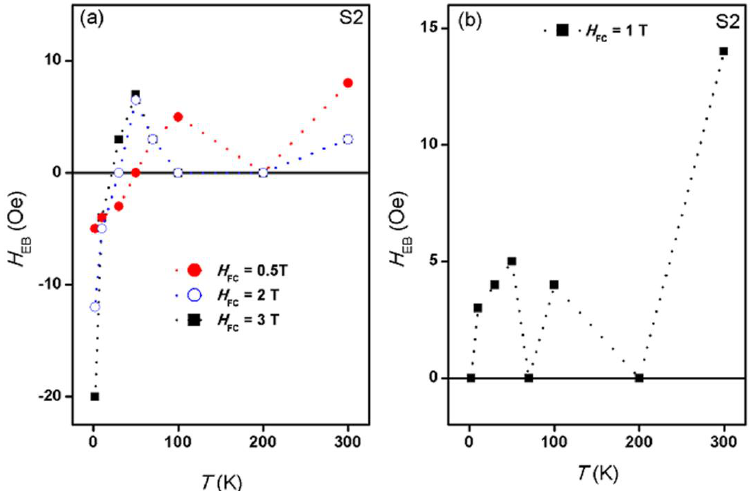
Figure 7. The temperature dependence of H EB in the temperature range of 2–300 K for sample S2 under ( a ) H FC = 0.5, 2, 3 T; and ( b ) H FC = 1